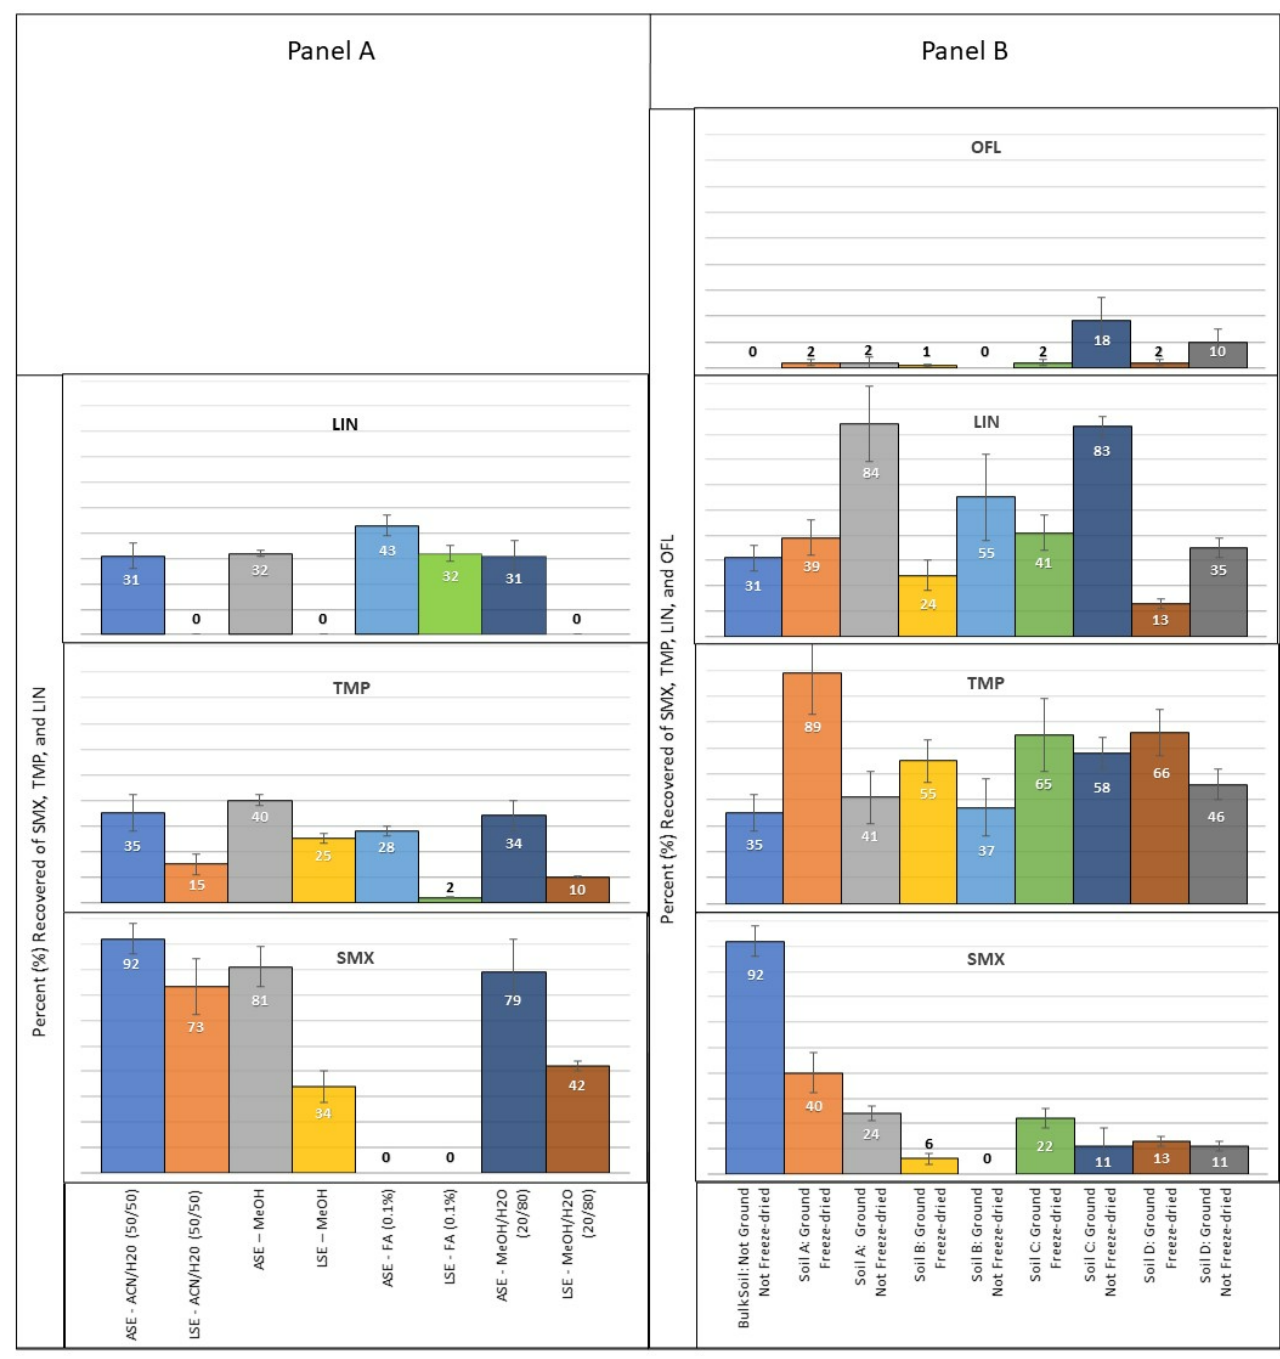
Figure 2. Average percent recoveries ( ± standard deviation) of sulfamethoxazole (SMX), trimethoprim (TMP), lincomycin (LIN), and ofloxacin (OFL) extracted from ( A ) bulk soil using accelerated solvent extraction (ASE) versus liquid solid extraction (LSE) with acetonitrile/water (ACN/H 2 O) (50/50), methanol (MeOH), formic acid (FA) (0.1%), or MeOH/H 2 O (20/80) and ( B ) bulk soil and four different soil types using ASE and ACN/H 2 O (50/50) that underwent different pre-processing steps (grinding and freeze-drying).